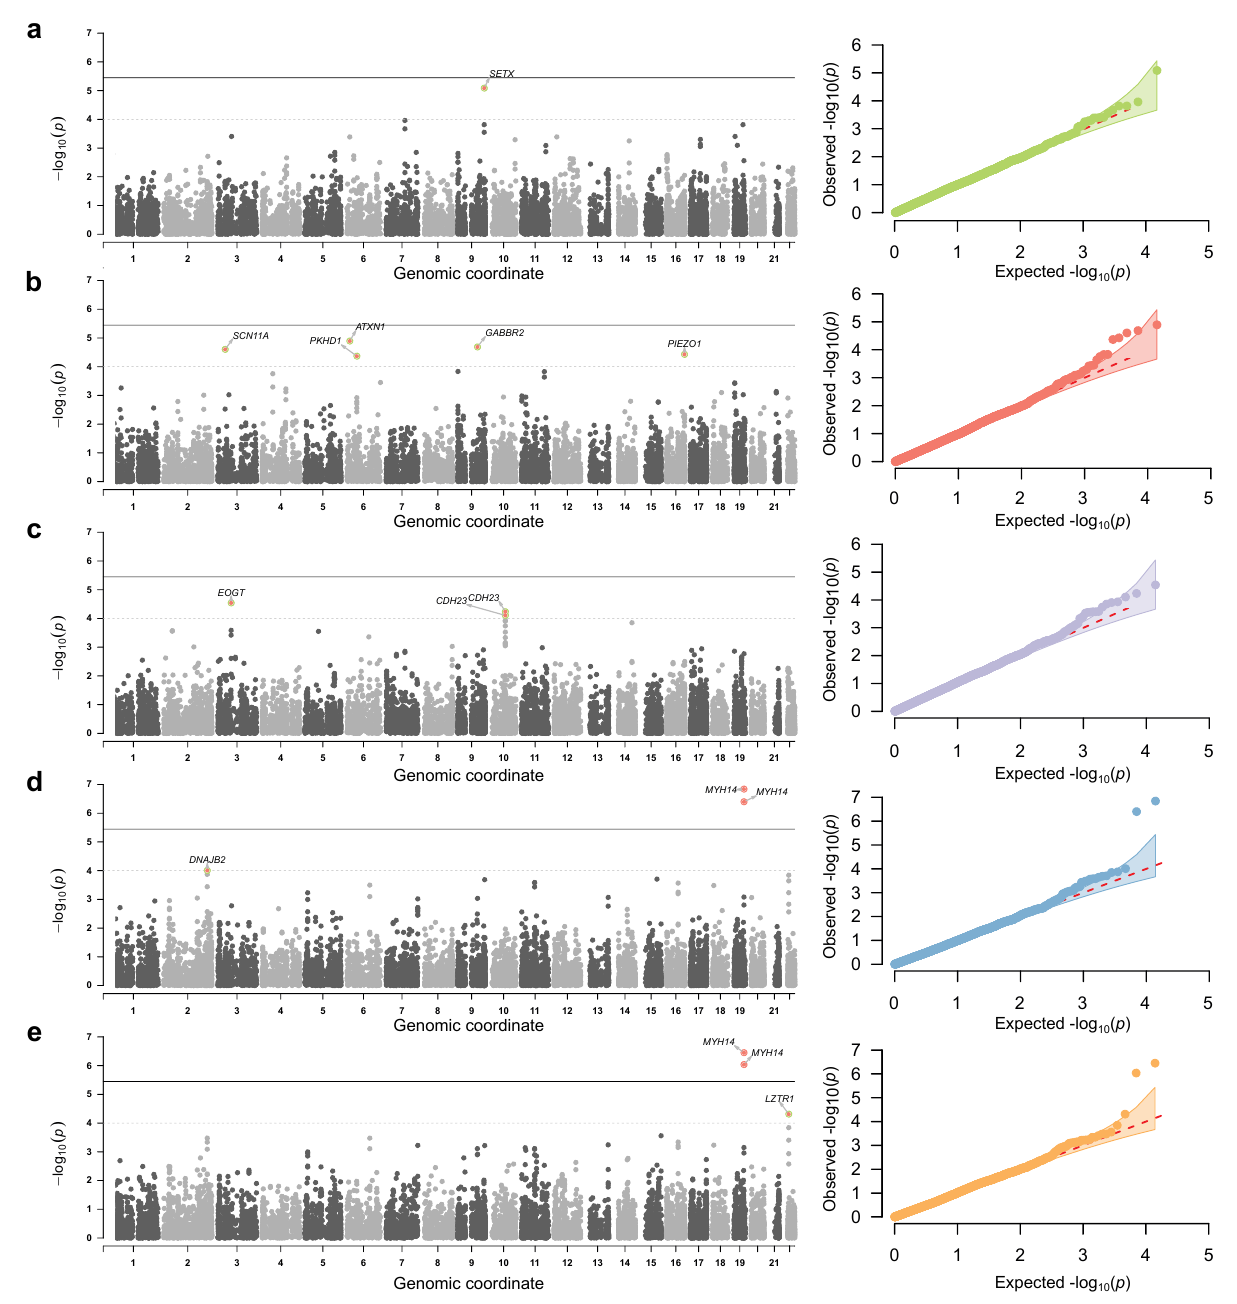
Figure 2. Genome-wide association results for selected quantitative traits in COVID-19 patients. Shown are Manhattan ( left ) and quantile-quantile ( right ) plots of association p -values for (from top to bottom) the serum CRP levels ( a ), CT-based lung involvement score ( b ), serum lymphocyte ( c ), leukocyte ( d ), and neutrophil ( e ) counts. Thresholds on the Manhattan plots correspond to the exome-wide significance cutoff (4 × 10 − 6 ) and the sub looser p = 10 − 4 cutoff used to select candidate